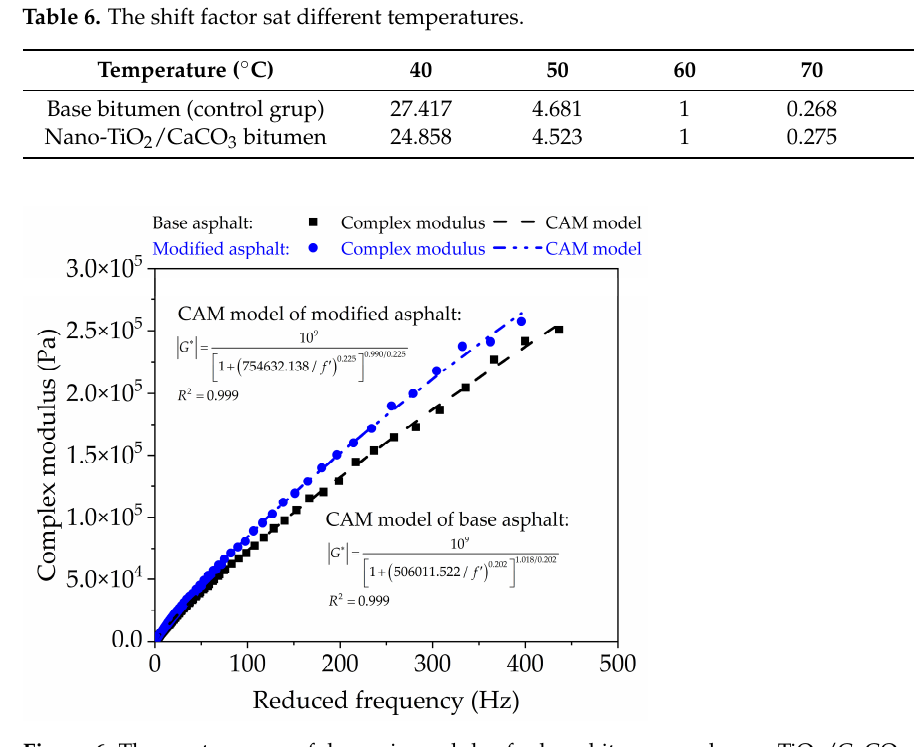
Figure 6. The master curve of dynamic modulus for base bitumen and nano-TiO 2 /CaCO 3 modified bitumen based on CAM model.